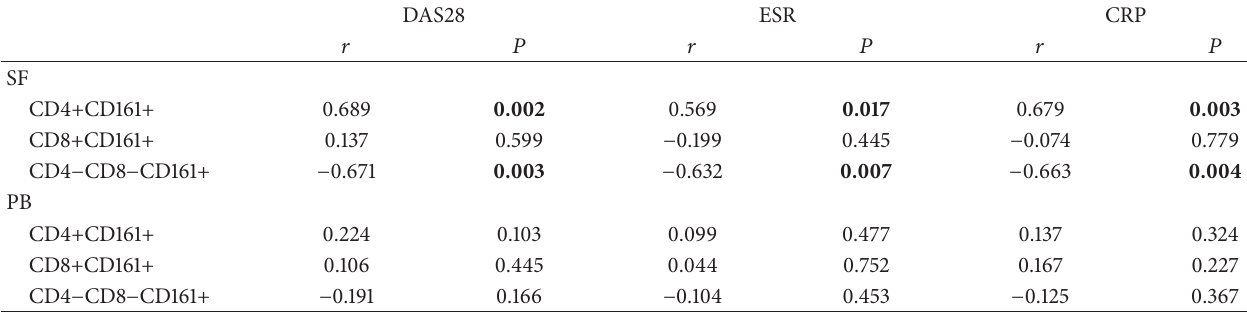
Table 2: Correlations between percentages of CD161+ T cell subsets in RA synovial fluid (SF) and peripheral blood (PB) and DAS28, ESR, and